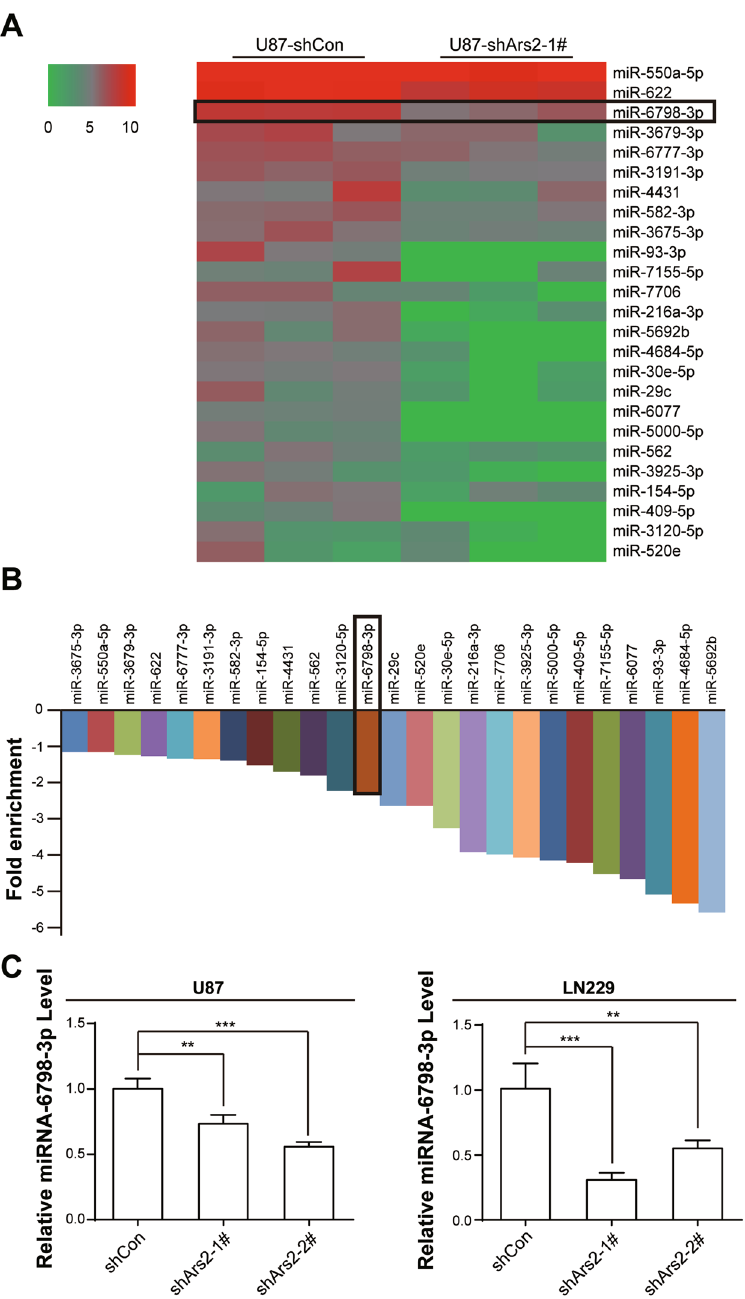
Figure 5. Depletion of Ars2 led to down-regulation of miR-6798-3p. ( A ) Heatmap showing differential miRNA expression between U87-shCon and U87-shArs2. ( B ) Analysis of down-regulated miRNAs in shArs2 cells and 25 down-regulated miRNAs (fold enrichment <− 1) were shown. ( C ) Relative miR-6798-3p levels in U87 and LN229 cells transfected with either shCon or shArs2 (shArs2-1#, and shArs2-2#). Data were represented as the mean ± SD for three separate experiments, * P < 0.05, ** P < 0.01, *** P <